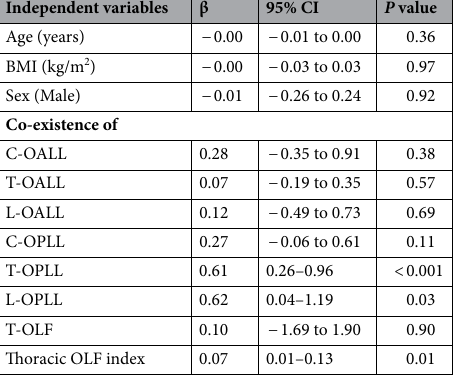
Table 4. Multiple regression analysis for factors associated with lumbar OLF index. β regression coefficient, CI confidence interval, BMI body mass index, OLF ossification of the ligamentum flavum, OALL ossification of the anterior longitudinal ligament, OPLL ossification of the posterior longitudinal ligament, C cervical, T thoracic, L